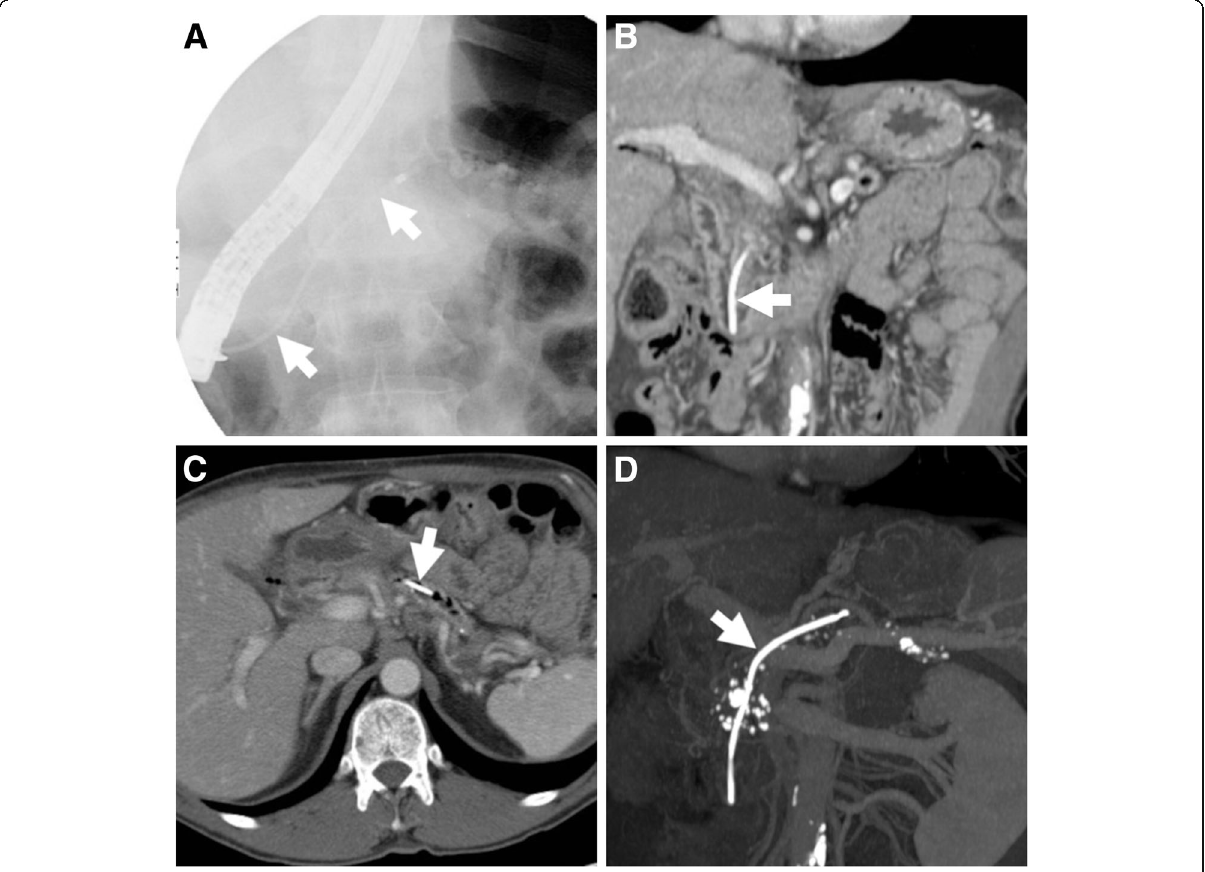
Fig. 10 In a 59-year-old male with CP, a long stent (thick arrow in a ) was placed to relieve hypertension of the MPD. Post-procedural MDCT ( b , c ) showed correctly placed stent (thick arrows) from near the Vaterian ampulla through the pancreatic midbody, without signs of complications. MIP reconstruction ( d ) confirmed stent integrity (thick arrow) and visualised entity and distribution of parenchymal pancreatic